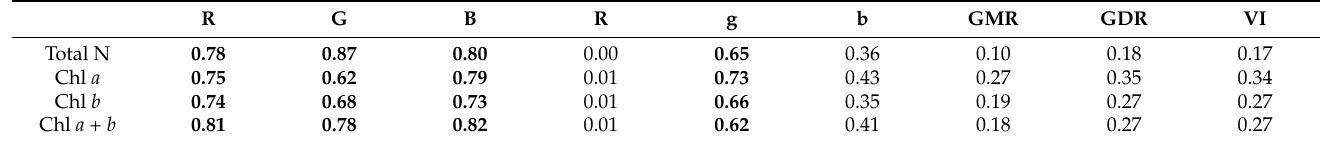
Table 6. Coefficients of determination (R 2 ) for the linear regression value between total N, Chl a , b and a + b and RGB values, rgb normalized values, and vegetation indices in R. officinalis .